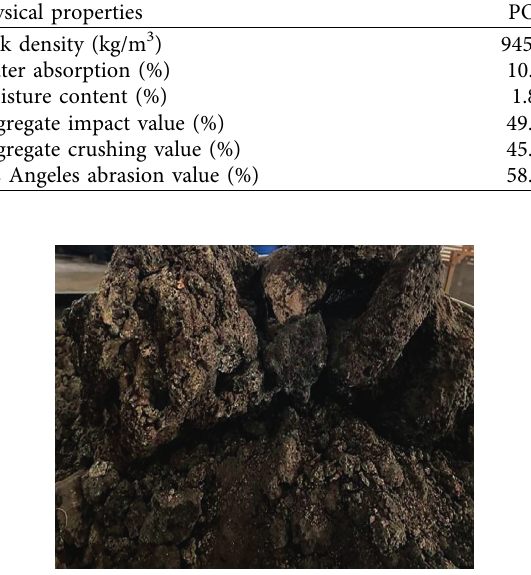
Figure 1: Large chunk of POC.